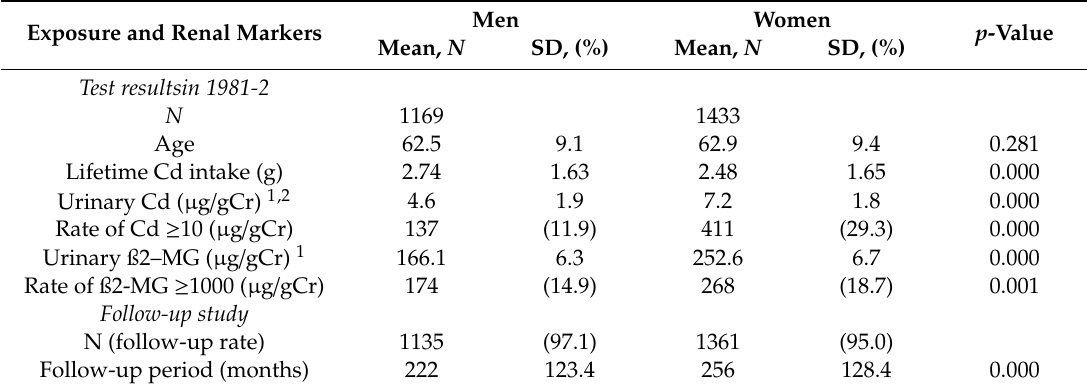
Table 1. Levels of external cadmium (Cd) exposure and renal dysfunction examined in the 1981–1982 health impact survey and the follow-up rates and period until